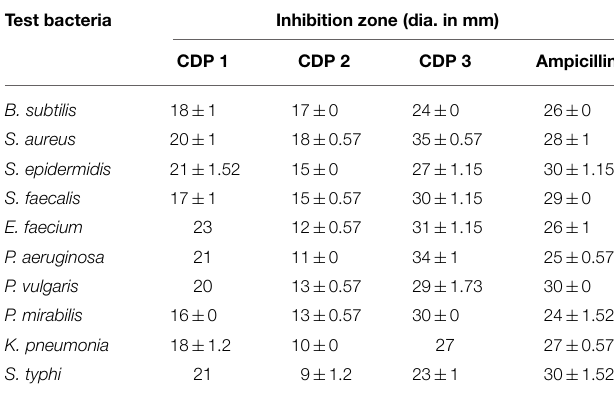
TABLE 3 | Antimicrobial activity of cyclic dipeptides against wound associated bacteria. Test bacteria